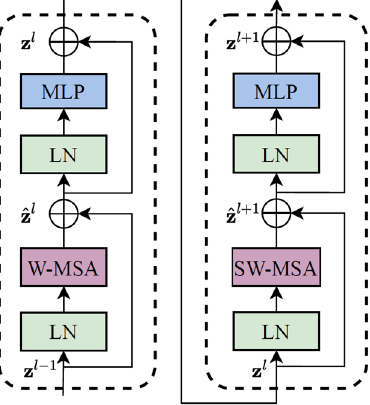
Figure 3. Backbone of the Swin Transformer.